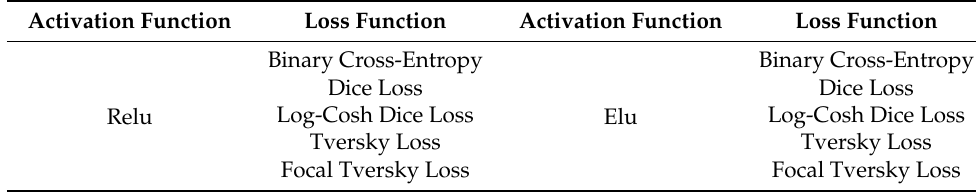
Table 5. Total combinations